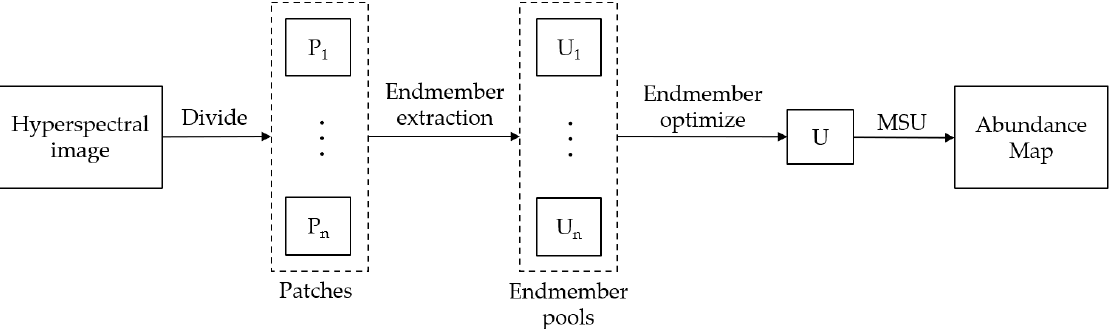
Figure 2. The flow chart of the MSU method.